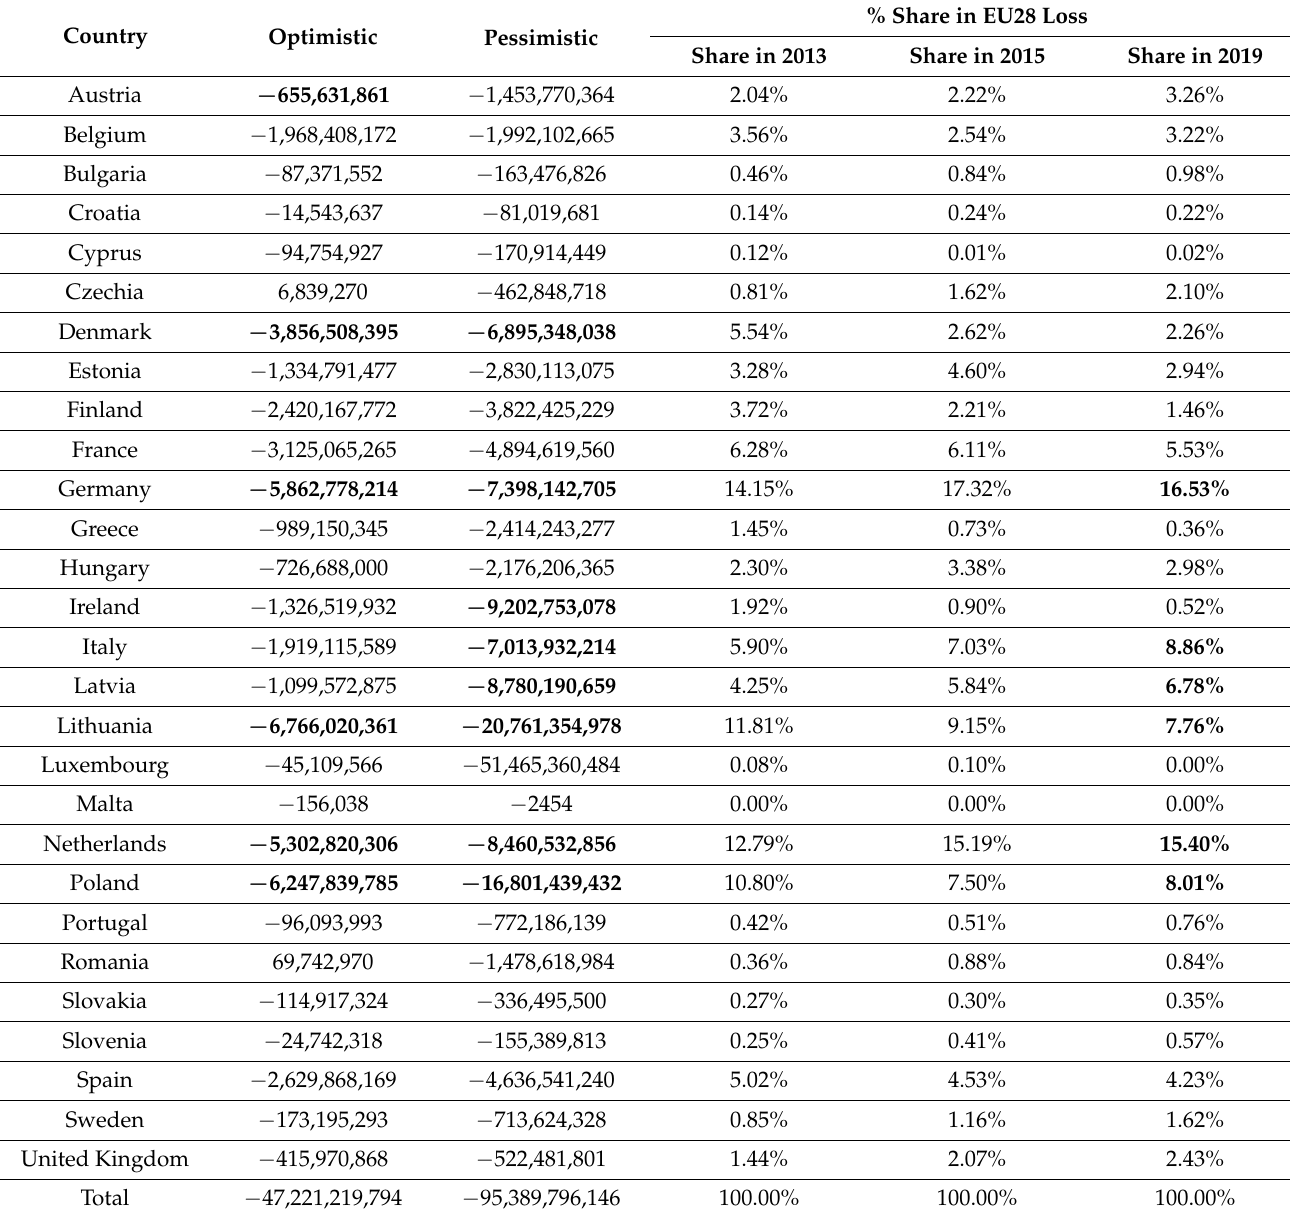
Table 4. Cumulative impact of the Russian import ban on agri-food trade of the EU28 with Russia for the period 2014–2019, in current USD (selected countries). Source: Authors’ own calculations based on UN COMTRADE